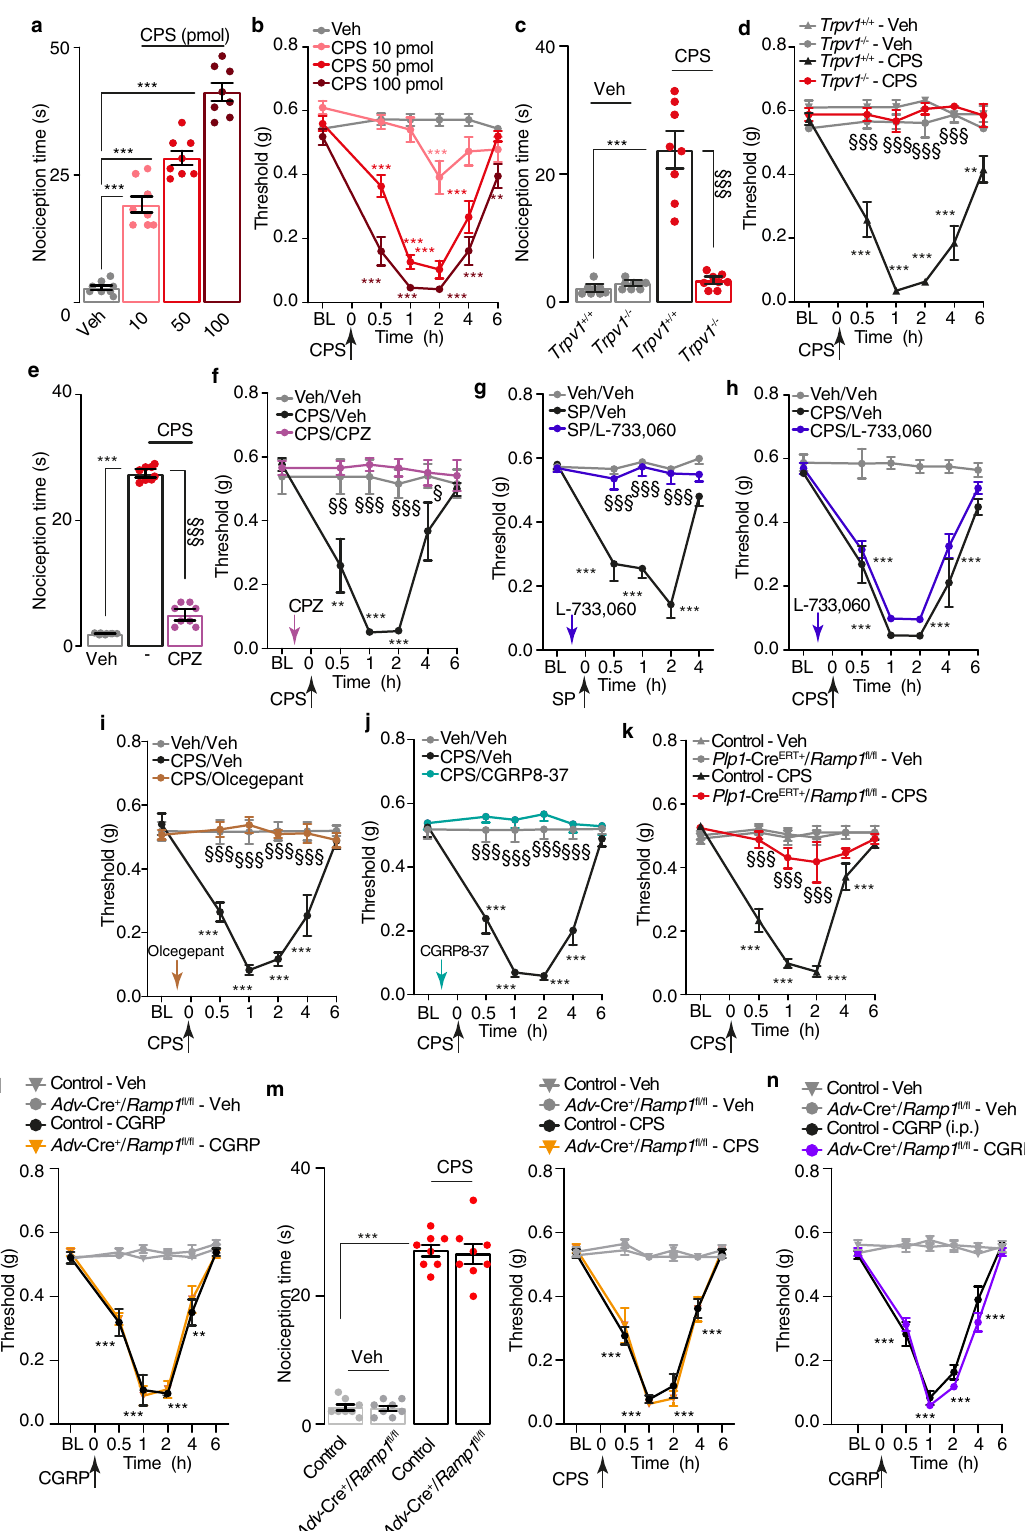
nociceptors ( Advillin-Cre + ;Ramp1 fl / fl , Adv-Cre + ;Ramp1 fl / fl ) and Control mice (Fig. 2l, m). Both PMA and paw allodynia were similar in Adv-Cre + ;Ramp1 fl / fl and Control mice after intraper- itoneal CGRP (Fig. 2n and Supplementary Fig. 3a). Thus, CGRP but not SP mediates allodynia resulting from excitation of TRPV1 + ve peptidergic nociceptors, and PMA evoked by